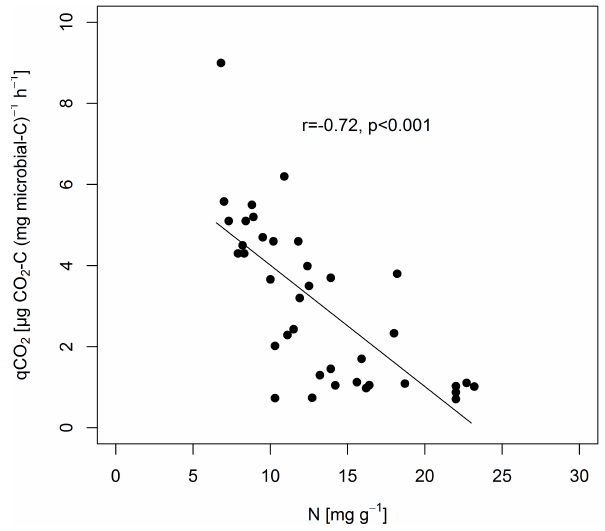
Figure 1. Correlation between the metabolic quotient ( q CO 2 ) and the molar carbon-to-nitrogen ratio (C:N) of the soil litter layer.